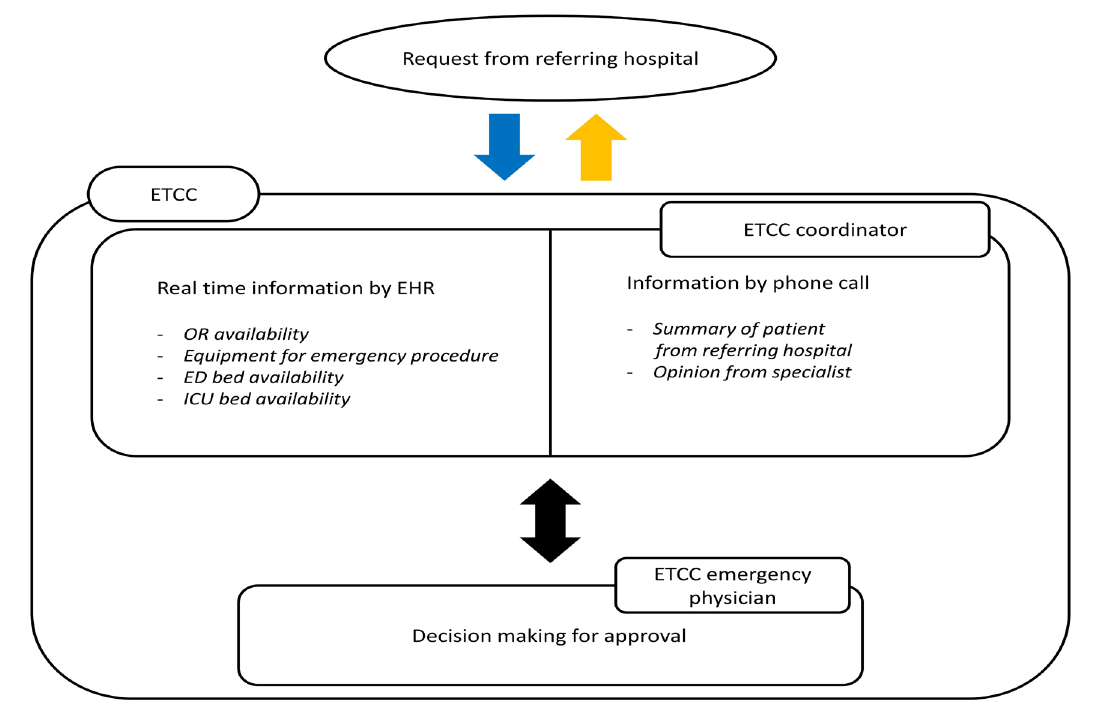
Figure 1. Flowchart of an emergency transfer coordination center decision-making process. EHR , electronic health record; OR , operating room; ED , emergency department; ICU , intensive care unit; ETCC , emergency transfer coordination